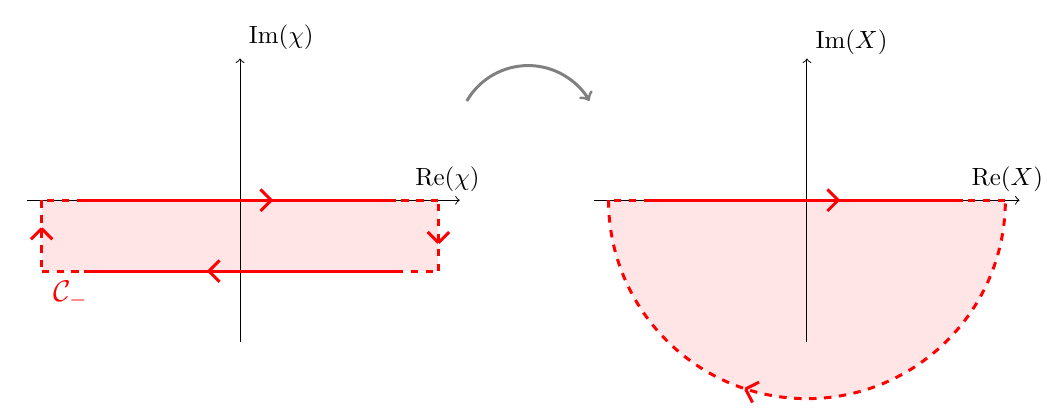
Figure 4 . Map of the contour C (cid:0) from the (cid:31) -plane to the X